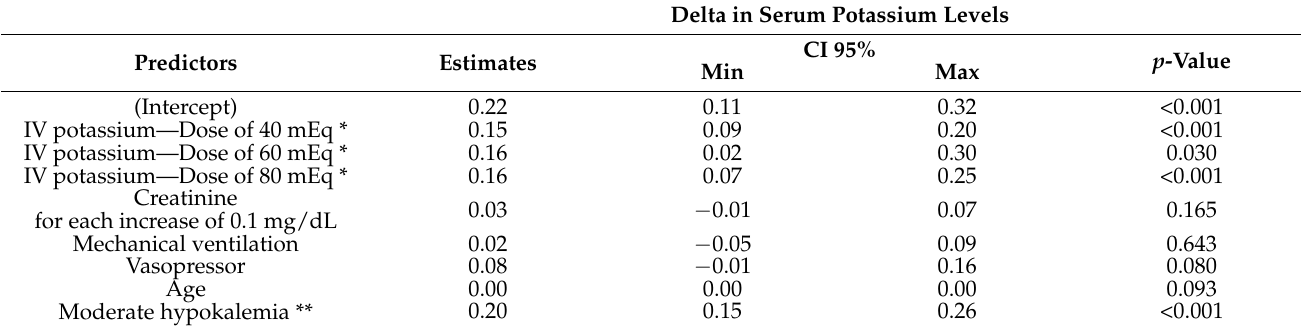
Table 4. Linear mixed model results for increases in serum potassium levels.